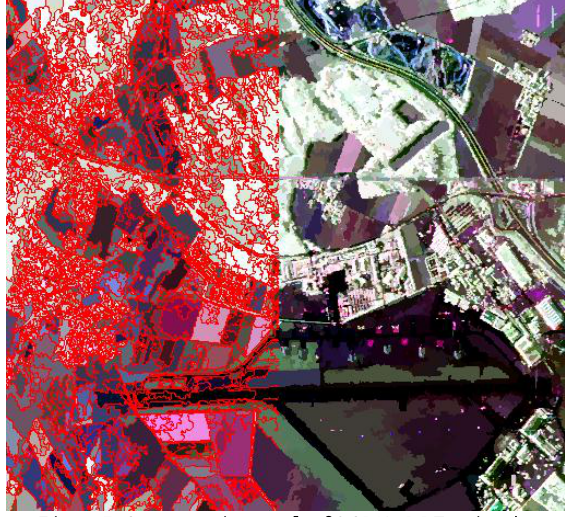
Figure 7. Segmentation result of GSRM-BPT using the homogeneity-based pruning